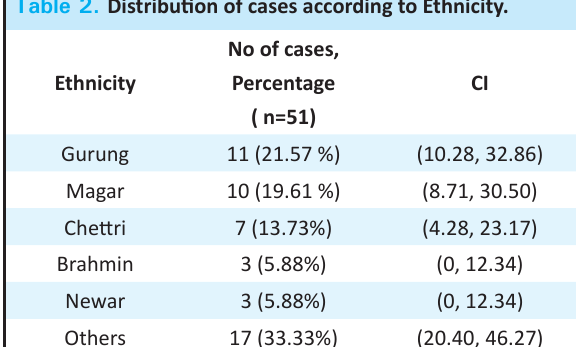
Table 2. Distribu ti on of cases according to Ethnicity.